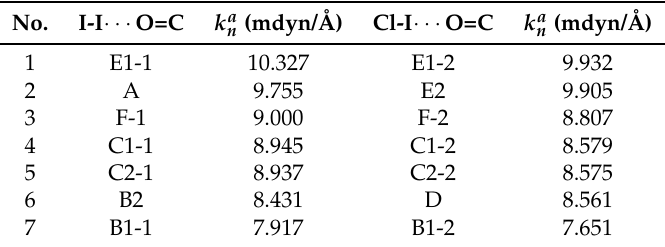
Table 2. Local stretching force constants of the C=O bonds for acceptor molecules A–F in descending order. No. I-I · · · O=C k a n (mdyn/Å)